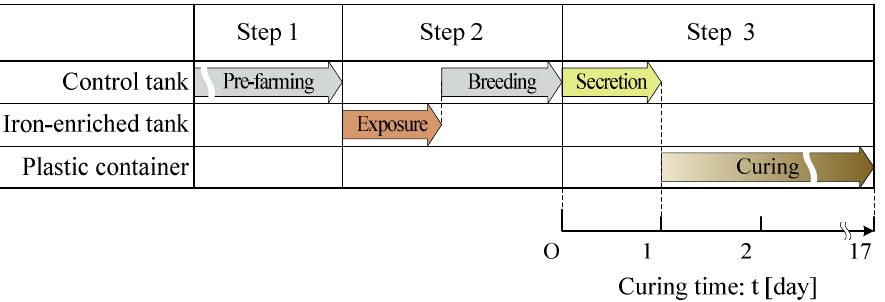
Fig. 3 Flow of specimen